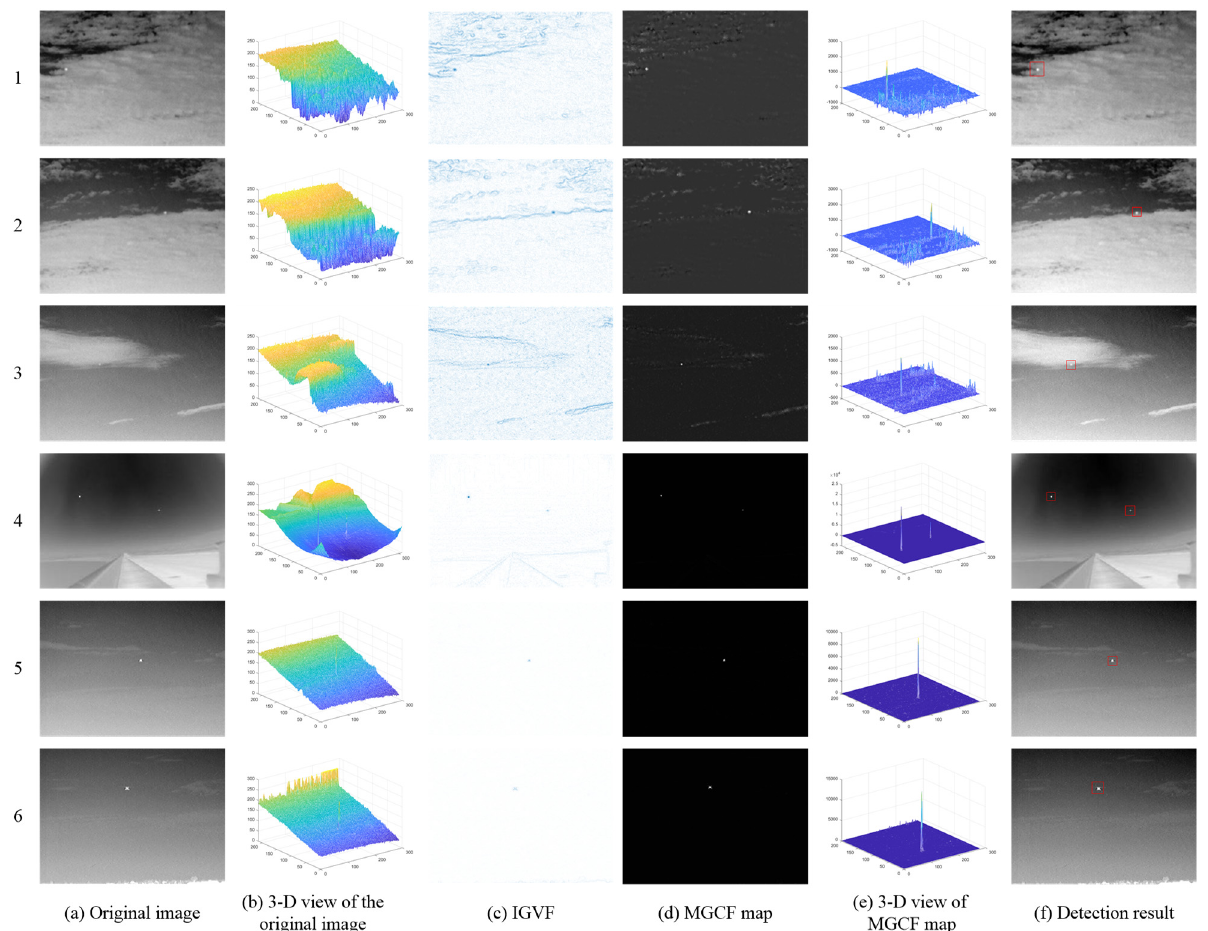
Figure 5. The experimental results of the proposed MGCF method under different backgrounds.